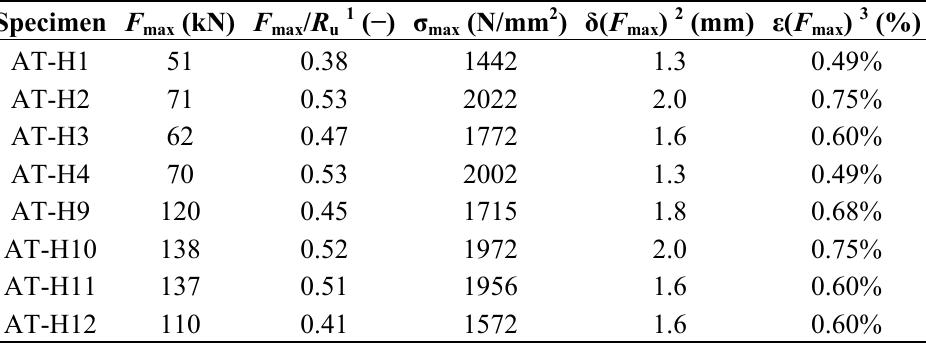
Table 6. Test results of Series